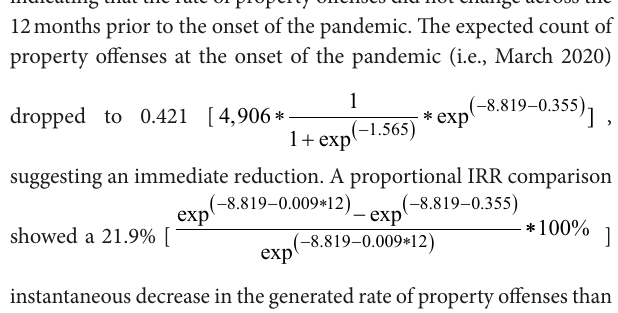
instantaneous decrease in the generated rate of property offenses than